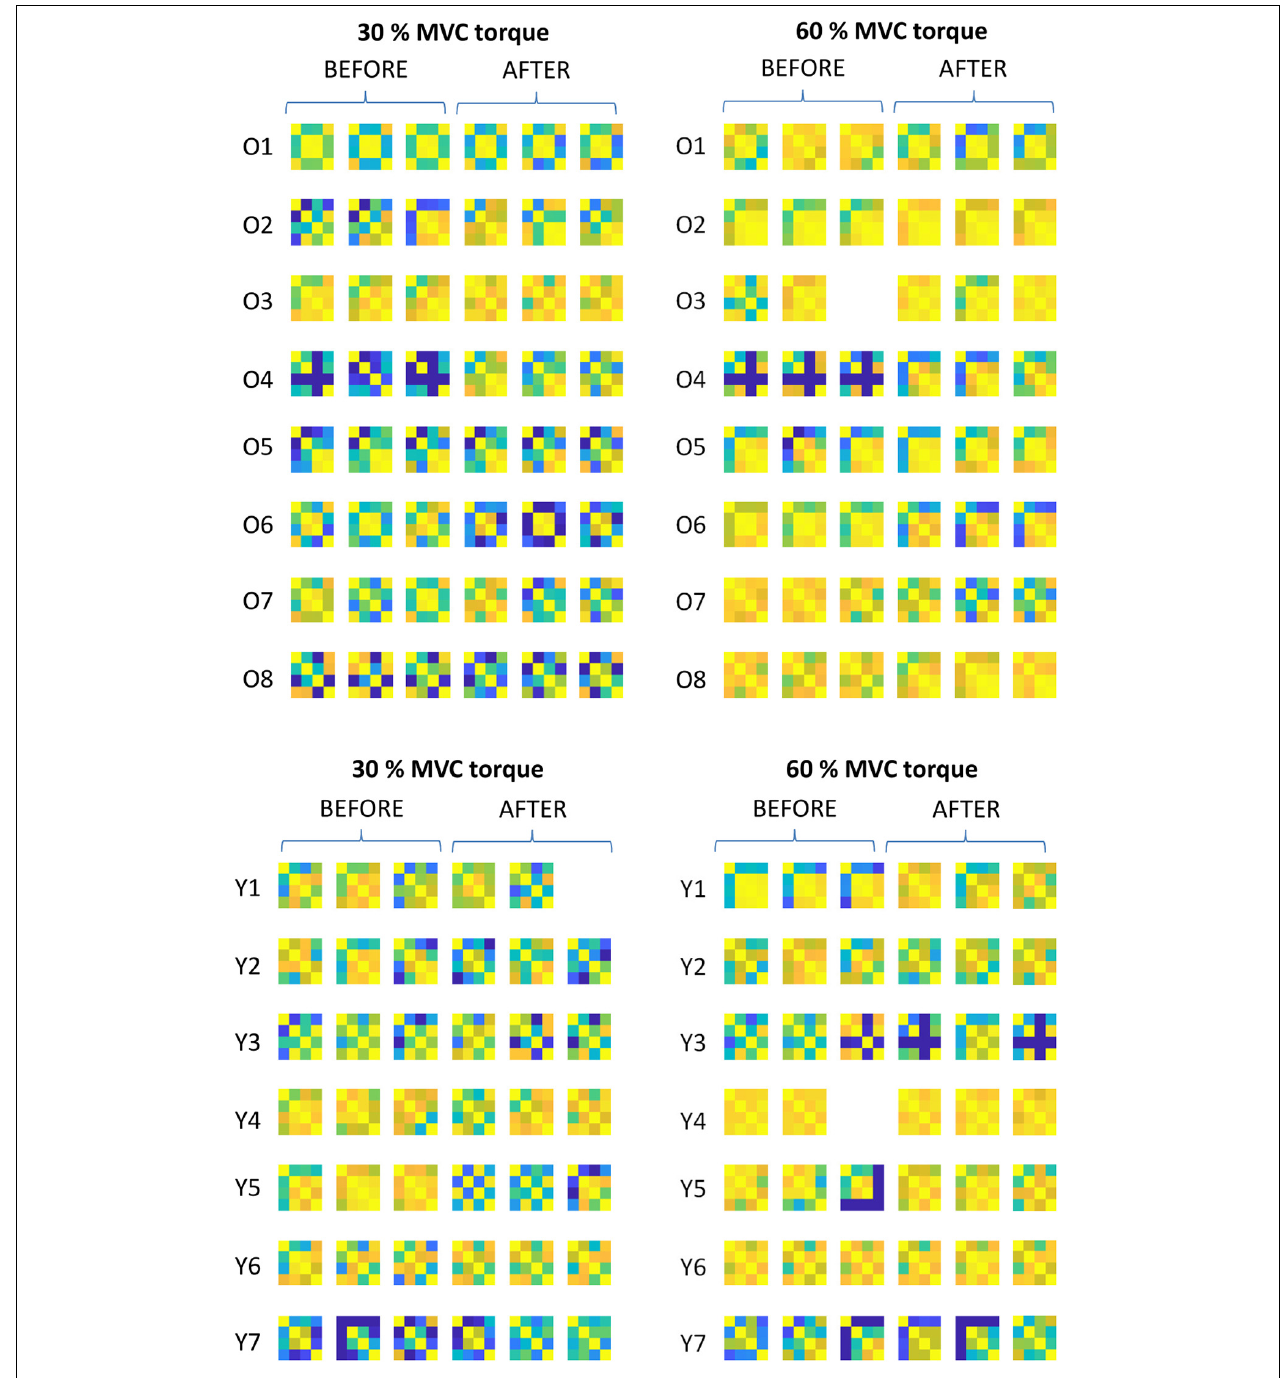
FIGURE 5 | Comparison of the muscle coactivation patterns in older (Oi) and young (Yi) participants across different trials at 30 and 60% MVC torque before (BEFORE) and after (AFTER) the bed rest. The muscle coactivation patterns are coded by pairwise cross-correlation of the cumulative spike trains of different muscles, in the same way as in the right panels of Figures 1 , 2 . Due to technical problems during the measurements one trial is missing in the O3, Y1, and Y4 participants.